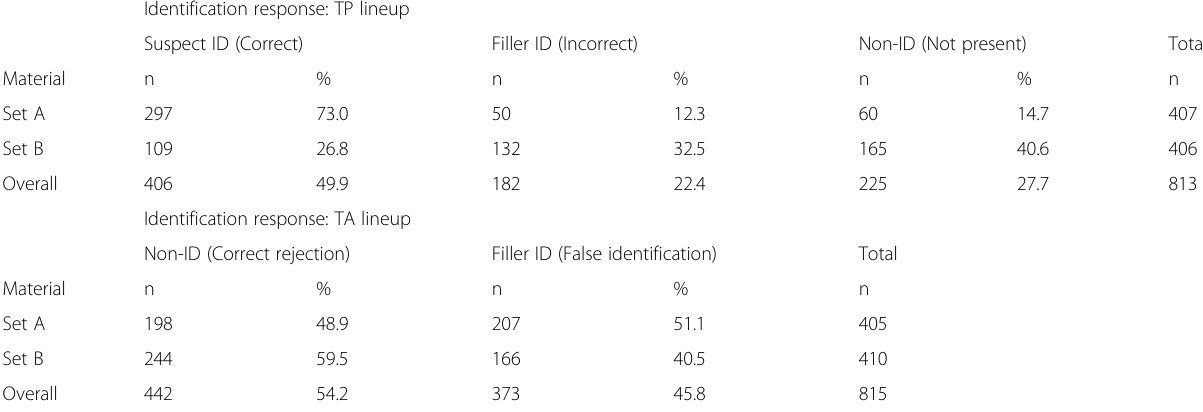
Table 1 Frequency and percentage of identification responses in each material set for target-present (TP) and target-absent (TA)